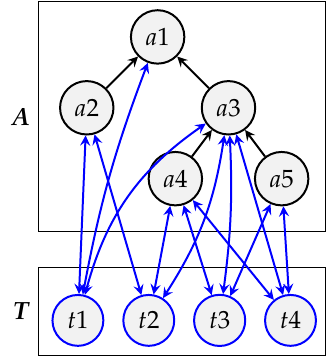
Figure 8. Routing graph G